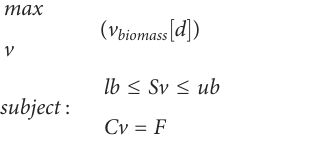
TABLE 3 Flux balance analysis equality, inequality, and fl ow ratio restrictions. [d] and [n] indicate day and night phase period respectively. Inequality constraints